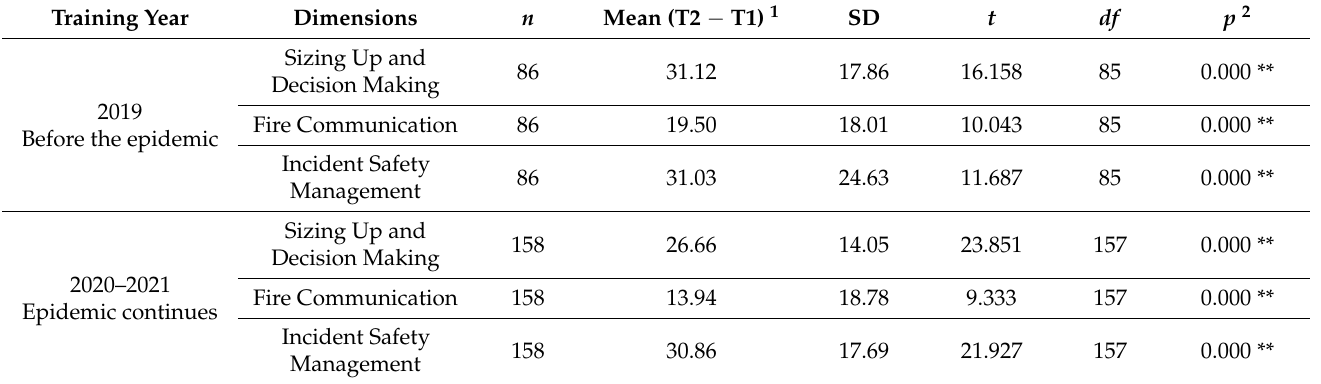
Table 6. T test analysis of trainees’ score progress before and after the epidemic.